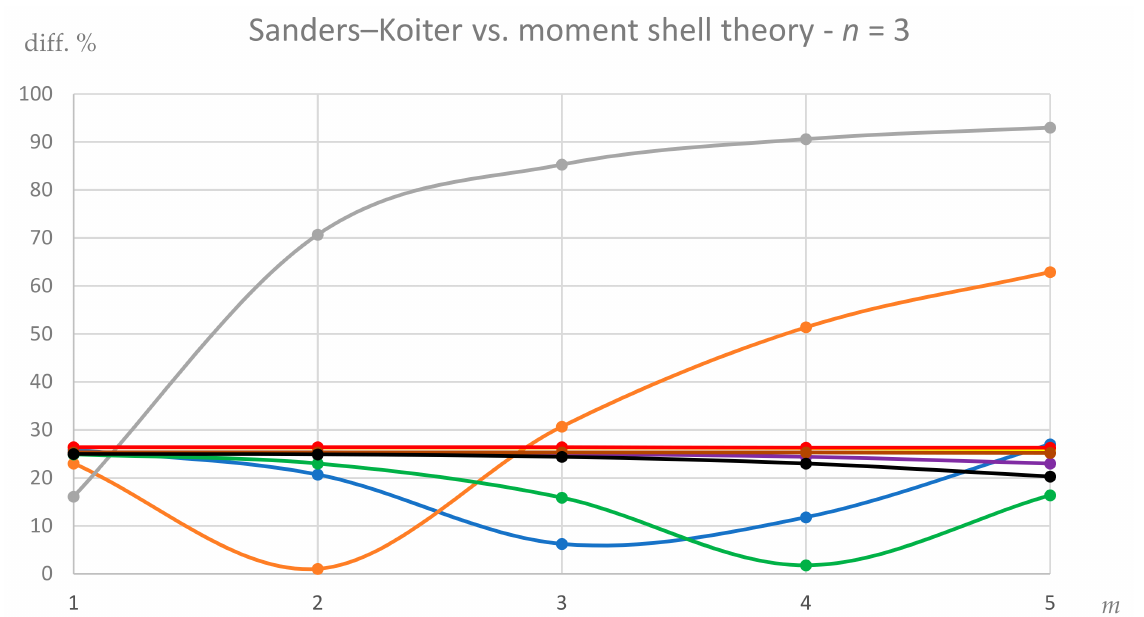
Figure 8. Simply supported DWCNT of Table 1 with different values of aspect ratio L / R 2 and thickness ratio R 2 / h . Shell-like modes ( n = 3). Comparisons between extended Sanders–Koiter and simplified moment shell theories, where L / R 2 = 10, R 2 / h = 25; L / R 2 = 10, R 2 / h = 50; L / R 2 = 10, R 2 / h = 250; L / R 2 = 50, R 2 / h = 25; L / R 2 = 50, R 2 / h =